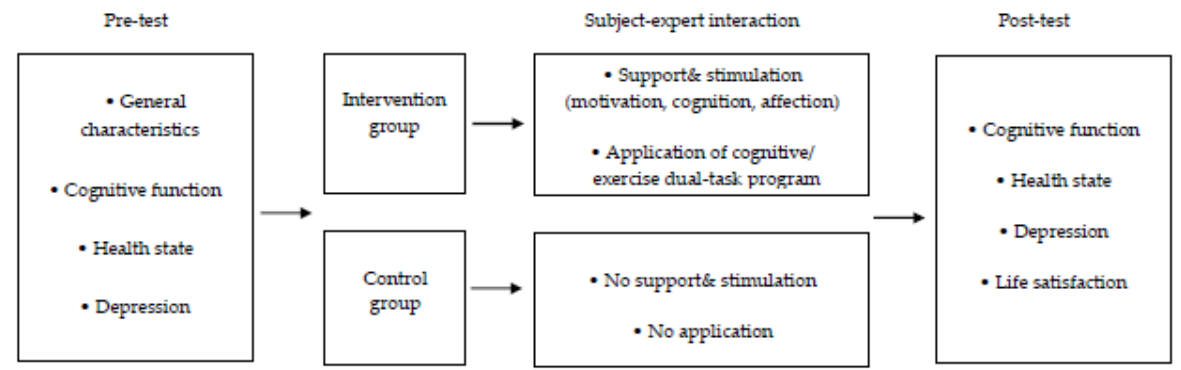
Figure 1. Conceptual framework of this study.